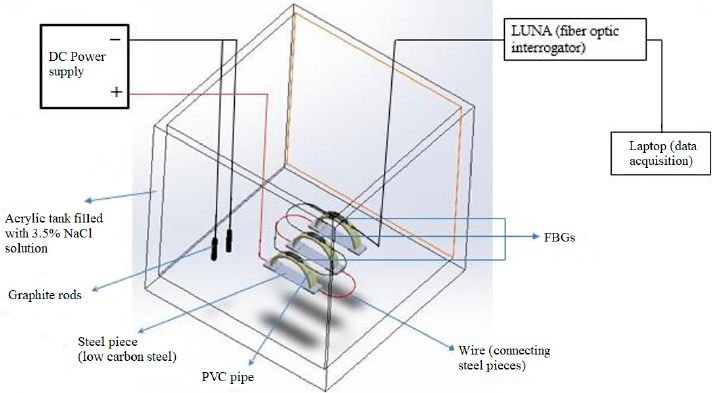
Figure 11. Schematic of the experimental test setup to test the proposed corrosion detection sensor.